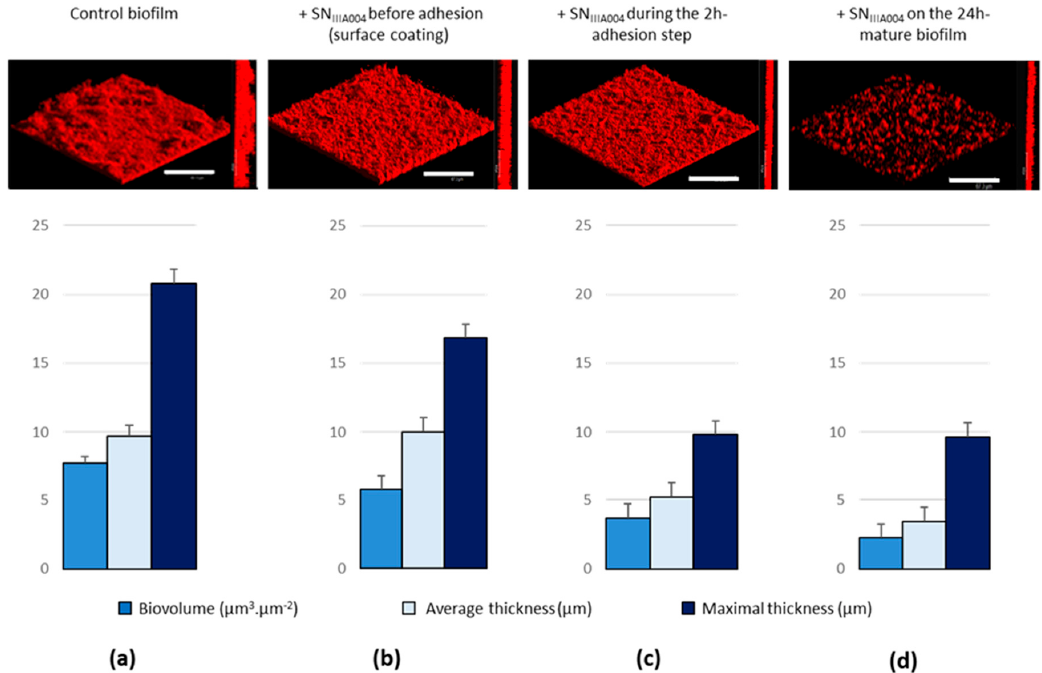
Figure 2. E ff ect of SN IIIA004 on the Roseovarius sp. VA014 biofilm formation in flow cell Figure 2. Effect of SN IIIA004 on the Roseovarius sp. VA014 biofilm formation in flow cell chambers .